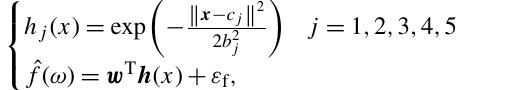
Figure 6. Input membership